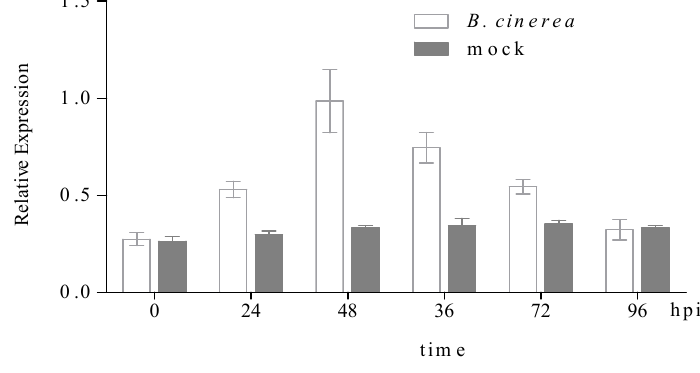
Figure 9. Expression of the CsHPL gene in No. 26 cucumber plants infected with Botrytis cinerea. Expression of the CsHPL gene in No. 26 cucumber plants infected with B. cinerea . The leaves of control plants were sprayed with mock solution (grey bars) or B. cinerea spores (white bars) and were harvested at the indicated time points. CsHPL expression levels were quantified by real-time polymerase chain reaction (PCR) and expressed as normalized expression to the cucumber reference gene actin expression level. Data are the mean of three independent experiments. hpi: hour post inoculation. B. cinerea : Botrytis cinerea ; mock, mock soluthion.